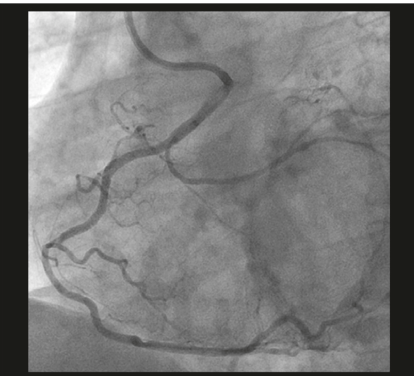
Figure 4: Final angiographic results after stent implantation and after